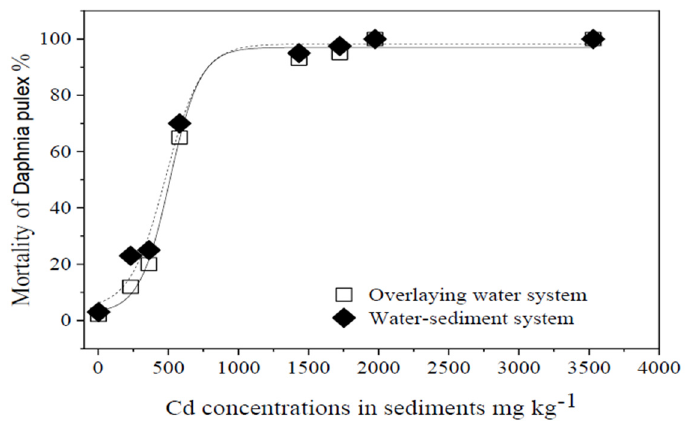
Figure 3. The mortality rate of Daphnia pulex under different Cd pollution levels in sediments (curves fitted by the Boltzmann function).